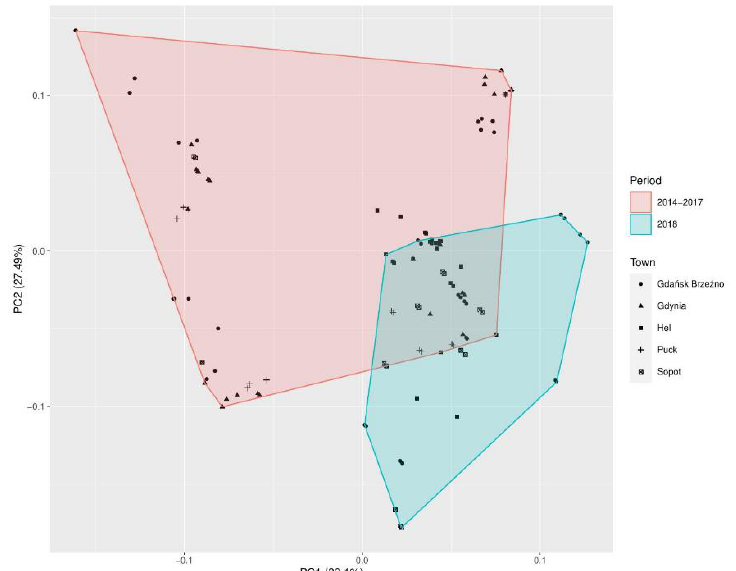
Figure 3. Principal component analysis (PCA) of Aspergillus sp. detected in air samples in the seaside towns (Hel, Puck, Gdynia, Sopot, and Gdańsk Brzeźno). The plot score of the first two principal components contained almost 60.59% of the explained variance. Two clusters can be distinguished: J. Fungi 2021 , 7 , 219 The red one is composed in the study period of 2014–2017 and the blue cluster in 2018.